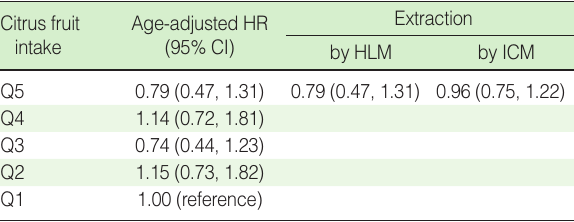
Table 1. An example of information extraction using the “highest versus lowest” method (HLM) and interval collapsing method (ICM)